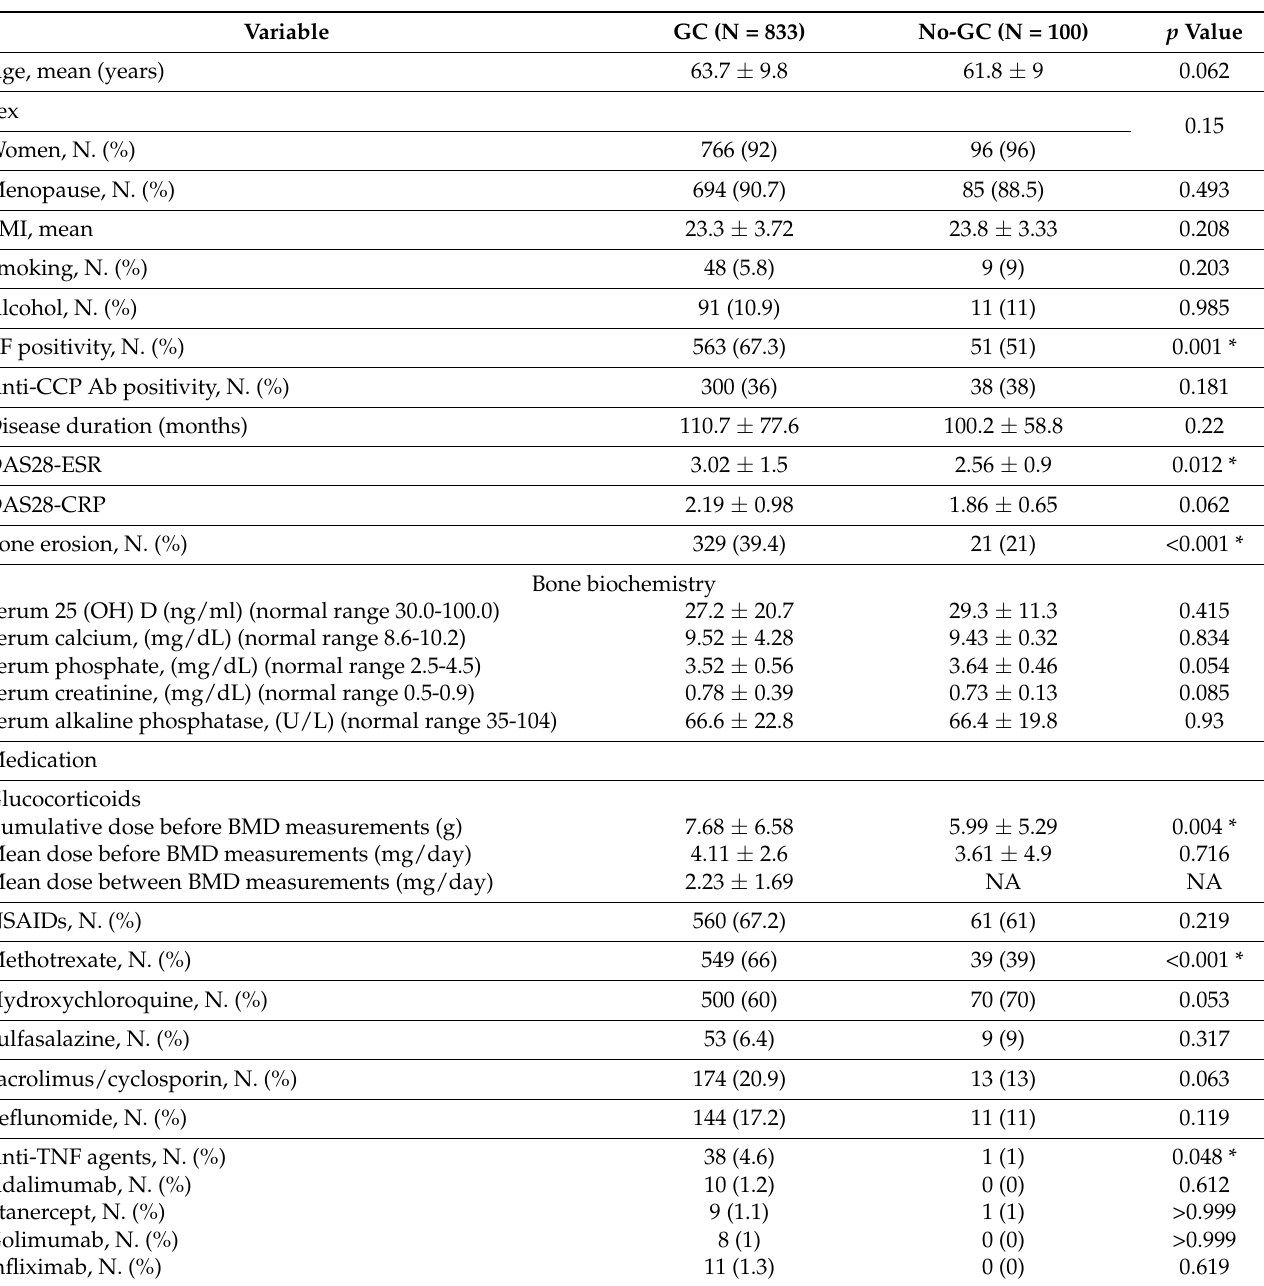
Table 1. Baseline demographic and clinical characteristics of patients with